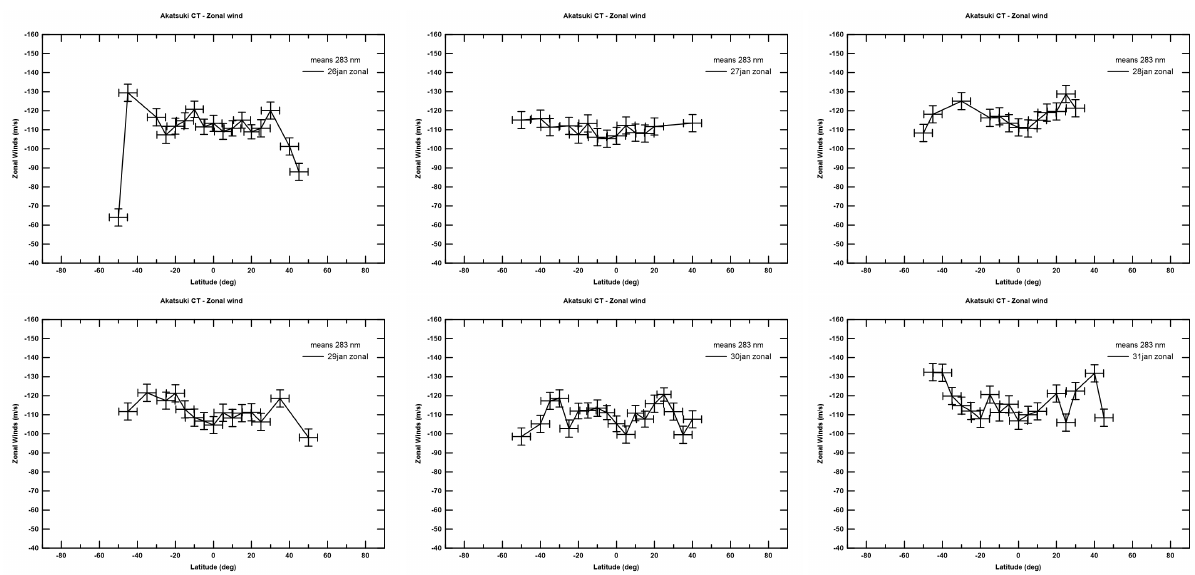
Figure 2. Six days of daily zonal wind latitudinal profiles retrieved from Akatsuki/UVI 283 nm images, from 26–31 January 2017. The values presented result from a weighted average at each latitudinal band sensed on each day, with a binning of 5 ◦ in latitude. The solid line represents the mean wind latitudinal profile and its respective error bars in velocity and latitudinal location. CT, cloud